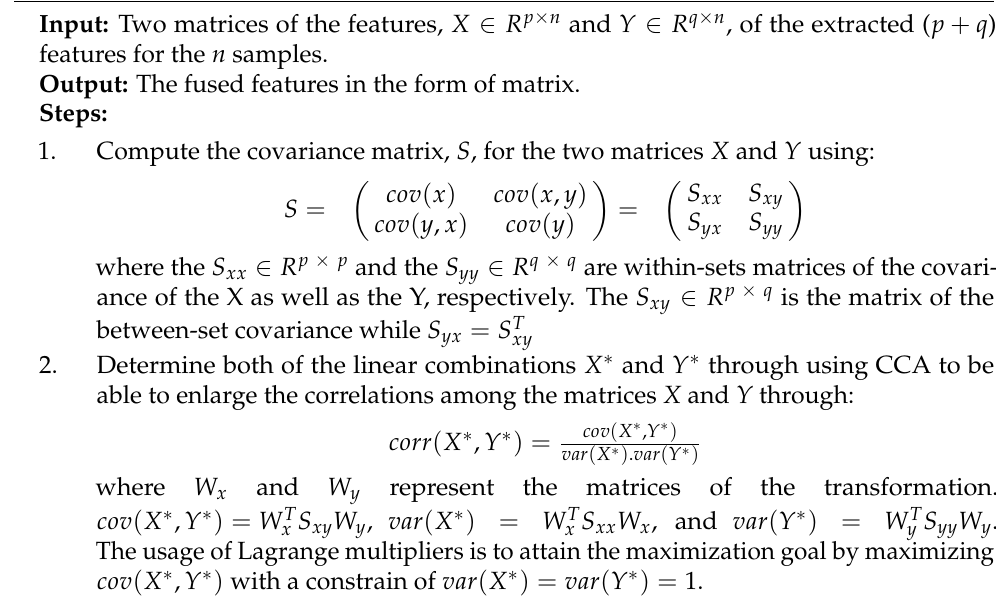
Algorithm 2 The algorithm for feature fusion based on CCA